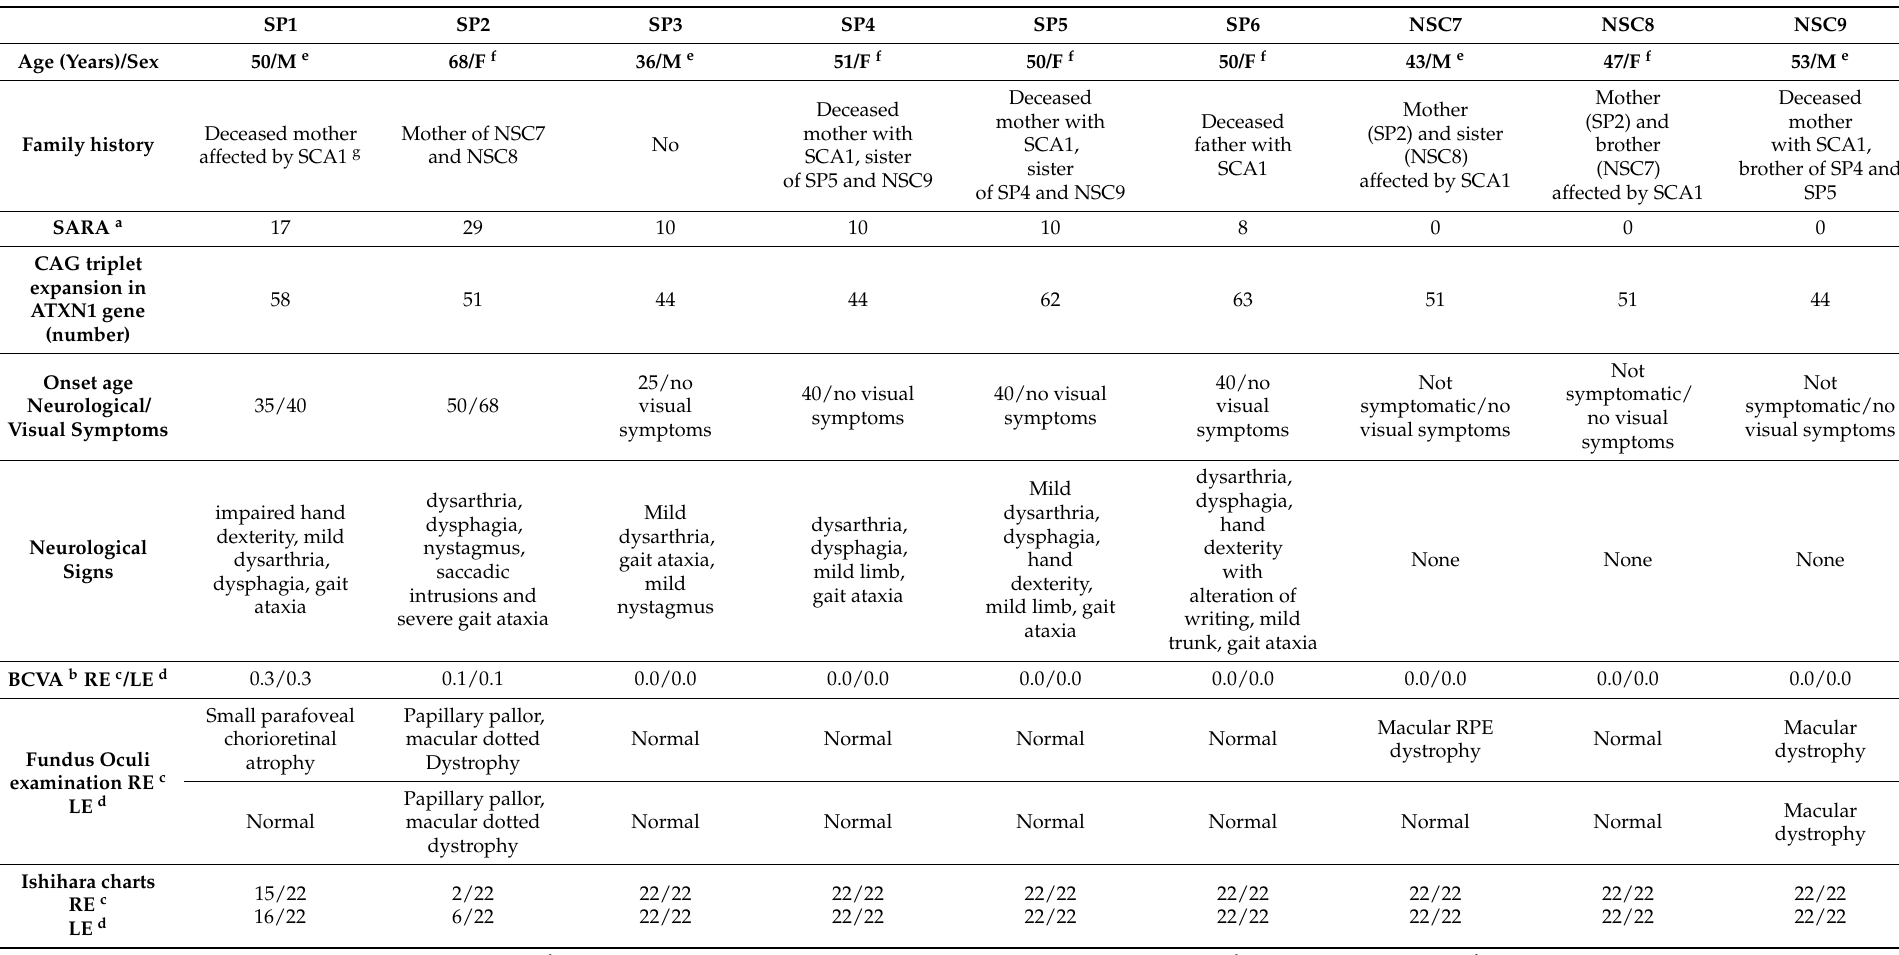
Table 1. Demographic, neurological and ophthalmological features of spinocerebellar ataxia type 1 patients with (SP) and without (NSC) neurological